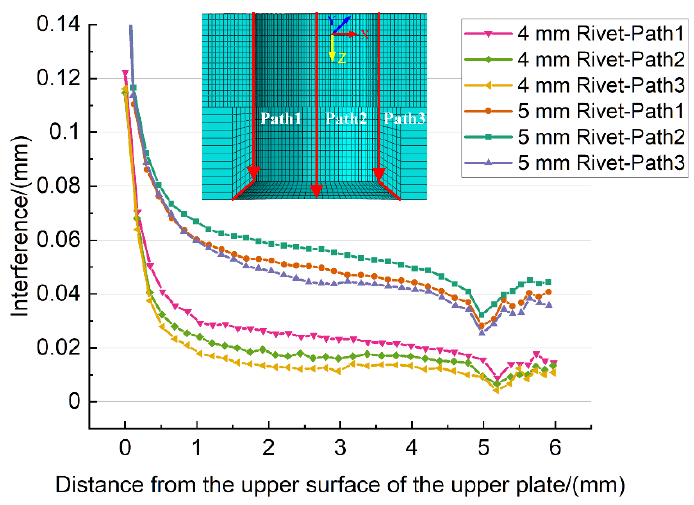
Figure 11. The interferences on the predefined paths along the axial direction of the riveted hole, the X-axis is from the upper surface of the upper plate to the lower surface of the lower plate.